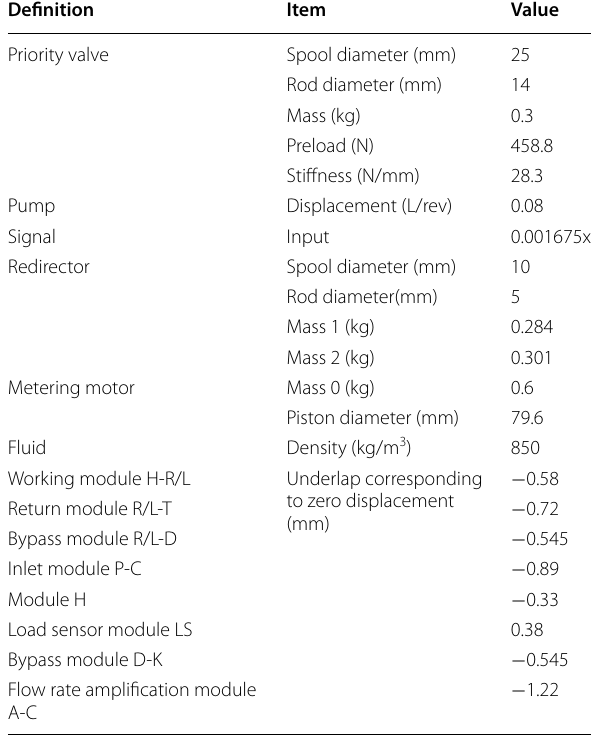
Table 1 Important parameters of the simulation